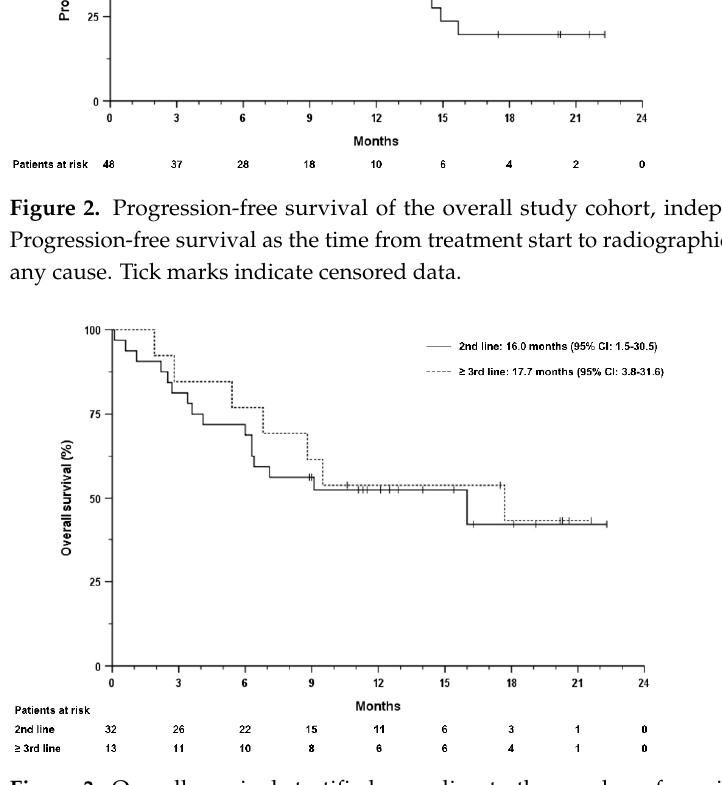
Figure 3. Overall survival stratified according to the number of previous therapy lines. Overall sur- vival was defined by the date of treatment initiation until death from any cause. Tick marks indicate censored data.